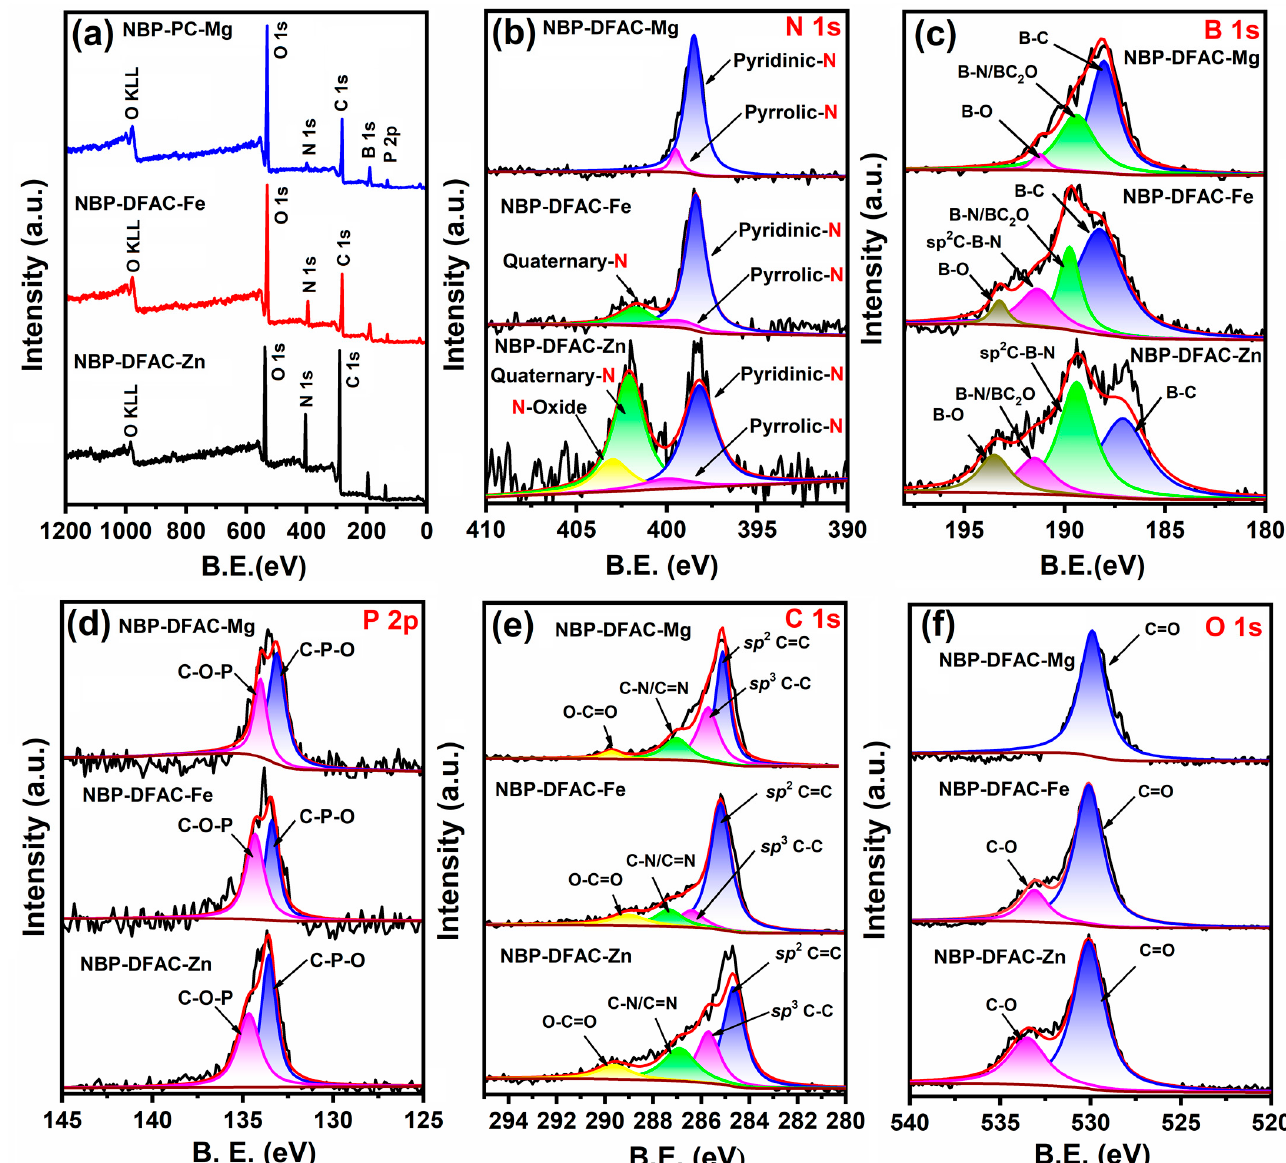
Figure 4. (a) XPS survey spectrum and (b-f) high resolution XPS spectra of N 1 s, B 1 s, P 2 p, C 1 s, Figure 4. ( a ) XPS survey spectrum and ( b – f ) high resolution XPS spectra of N 1 s, B 1 s, P 2 p, C 1 s, and O 1 s. and O 1